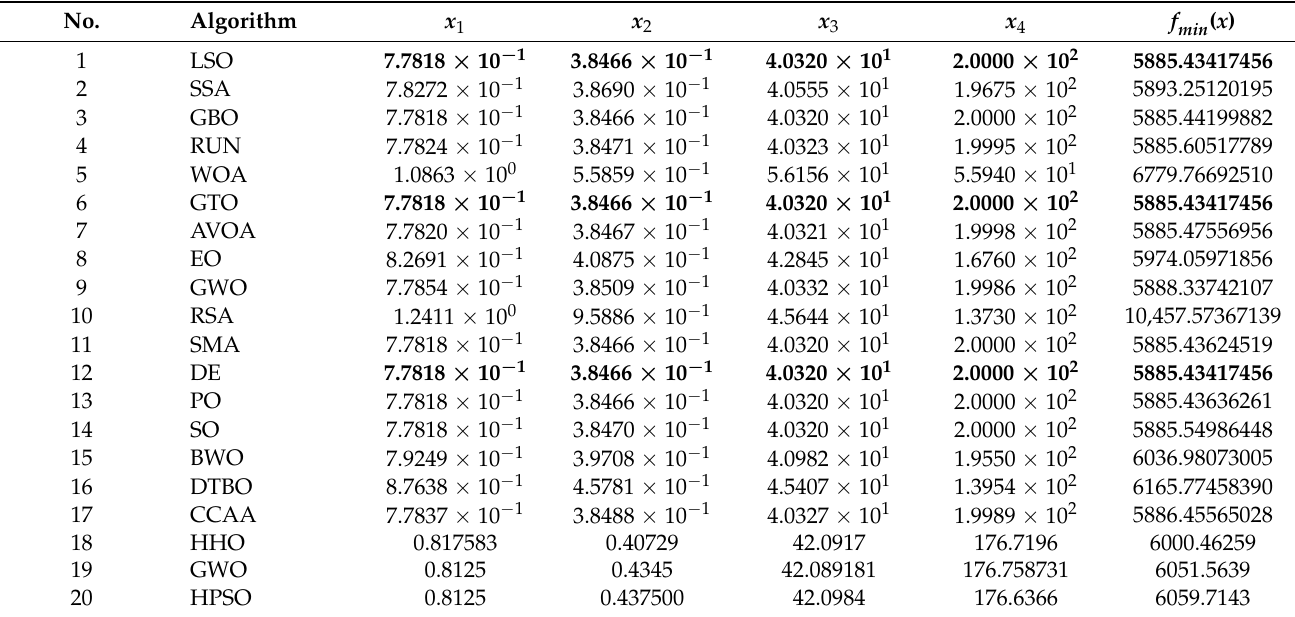
Table 19. Comparison of the results for pressure vessel design optimization